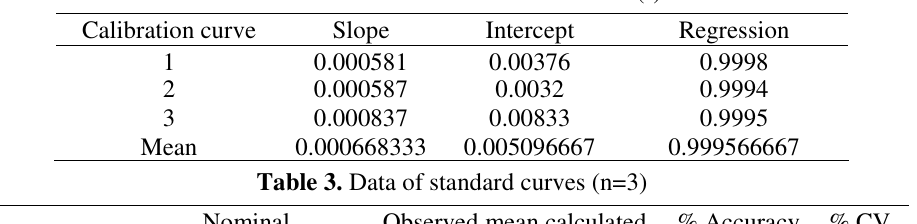
Table 2. Data of correlation coefficient(r)